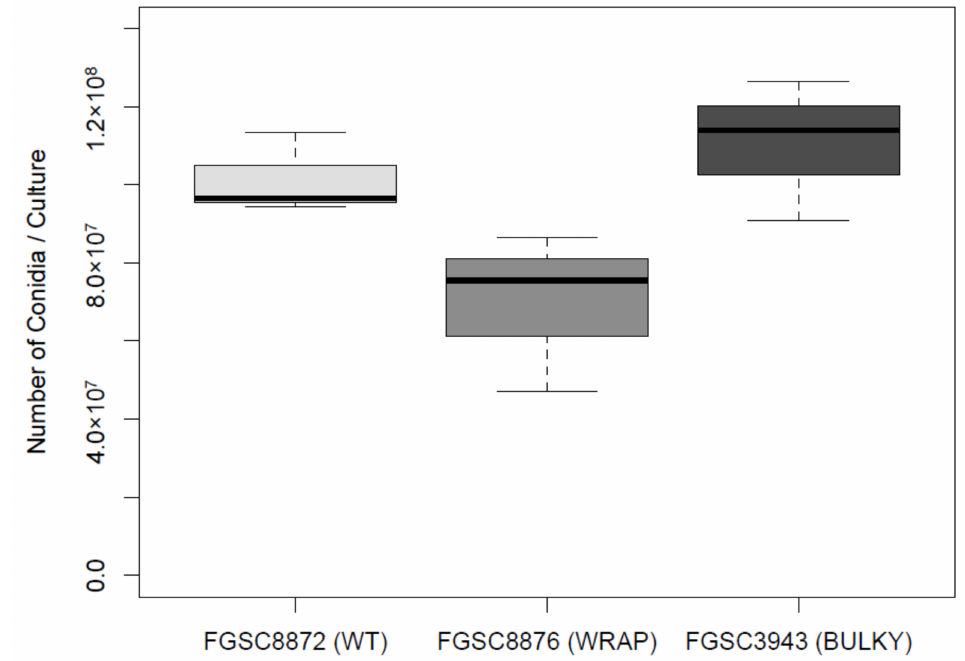
Figure 7. Number of conidia suspended in water from an 82 mm diameter nitrocellulose membrane by each conidiophore phenotype. The dataset includes three biological replicates. The box shows the 25th and 75th percentiles, with the median denoted as a line inside. The whiskers represent the range of data. The t -test results for pairs are as follows: WT–Wrap, p = 0.09541; Wrap–Bulky, p = 0.06079; WT–Bulky, p =